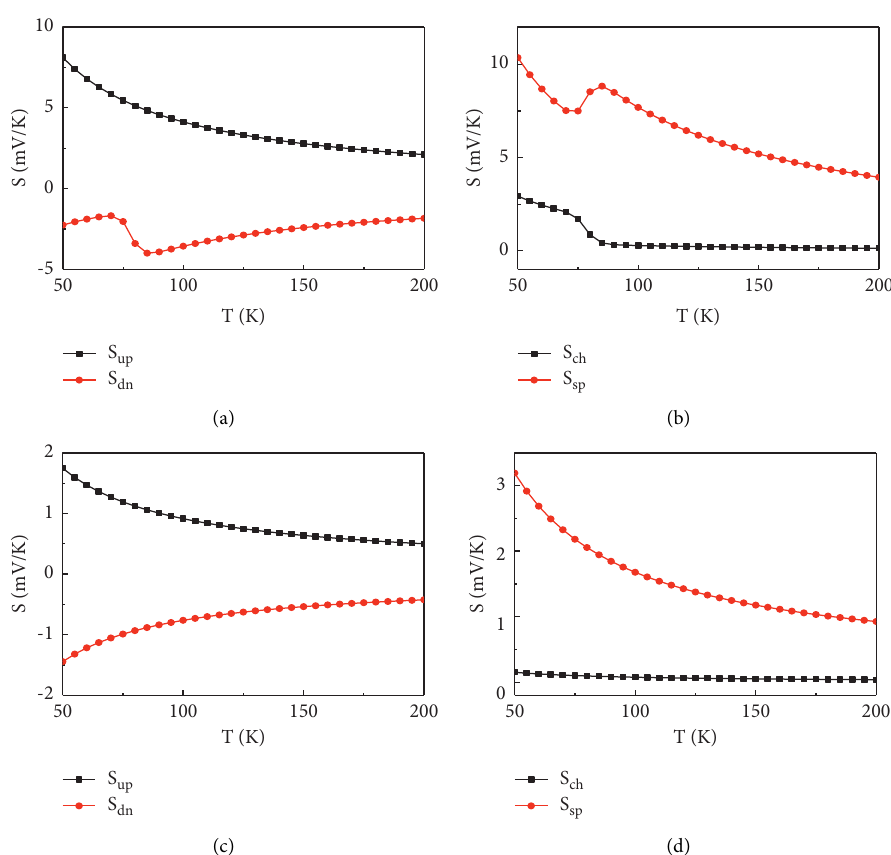
Figure 7: The spin-dependent Seebeck coefficients S up and S dn , charge Seebeck coefficient S ch , and spin Seebeck coefficient S sp as a function of device temperature T at the zero chemical potential ( µ � 0). (a, b) Results of 4-ZKGNR; (c, d) results of